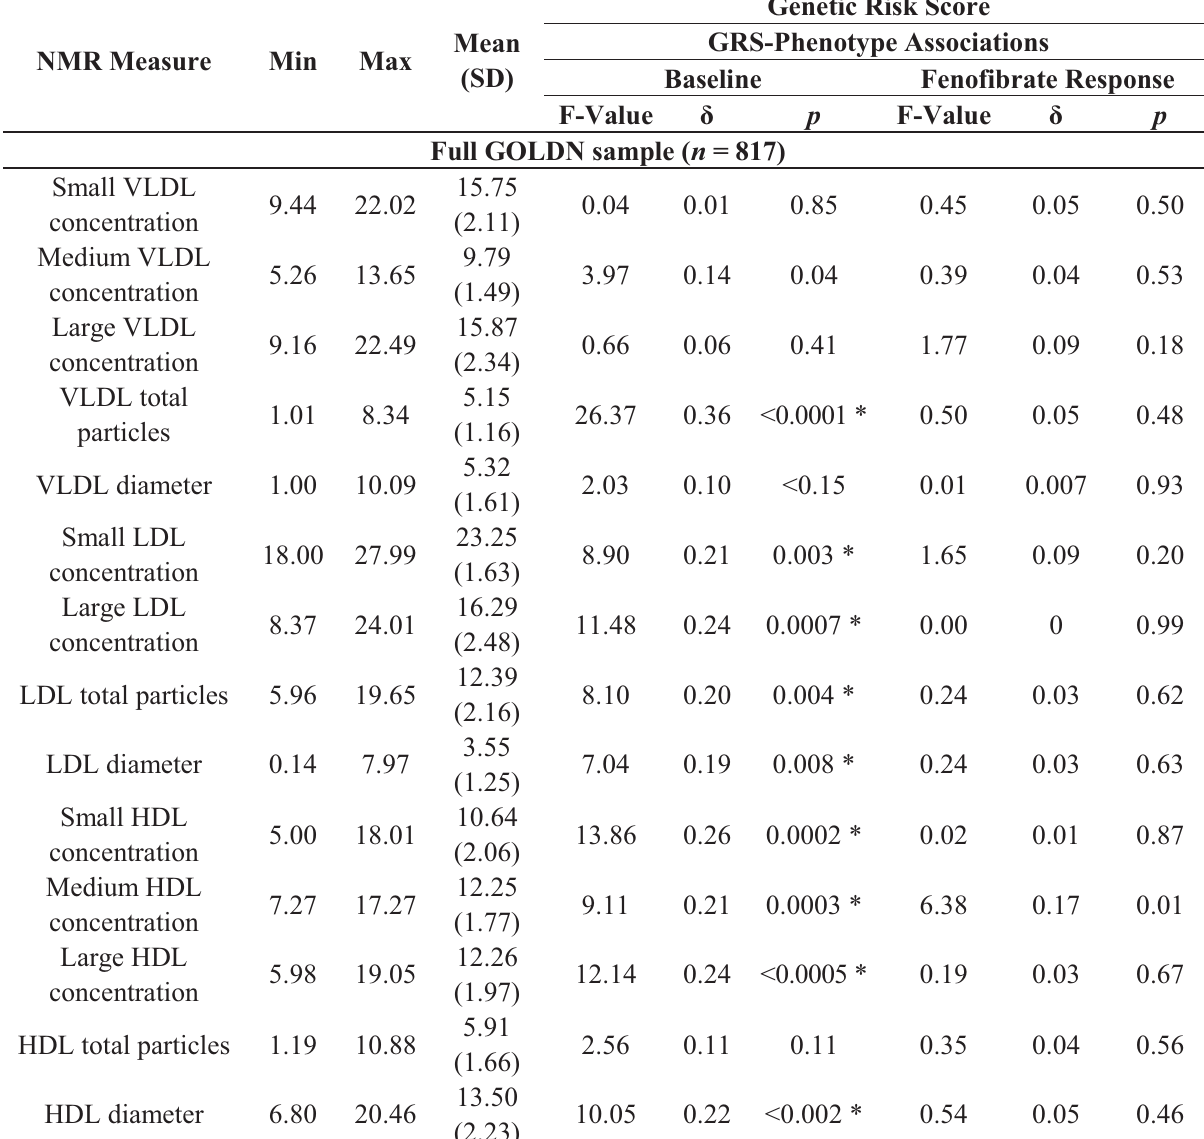
Table 3. Associations between genetic risk scores and baseline NMR measures, and between genetic risk scores and the response of NMR measures to a 3-week fenofibrate